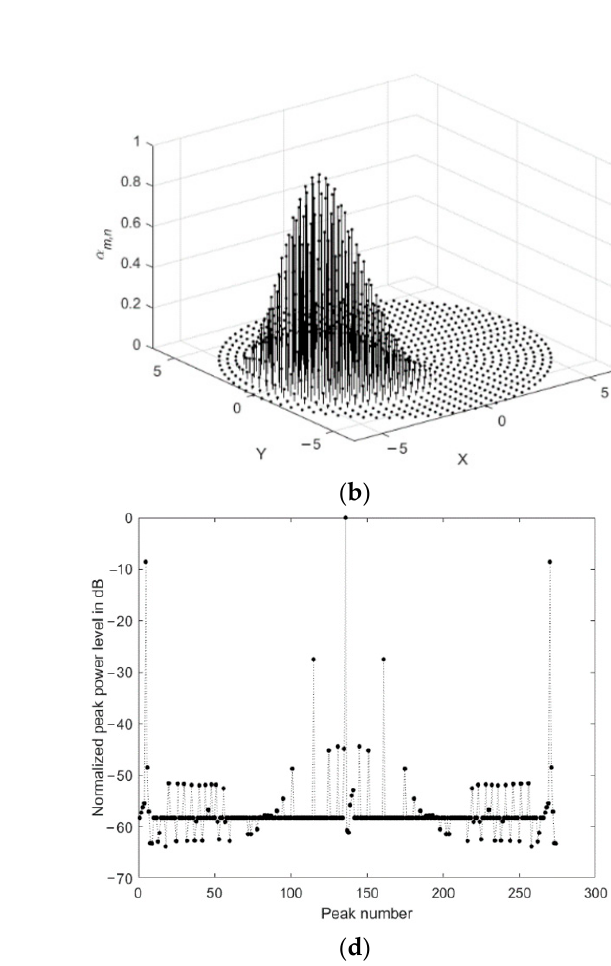
Figure 13. Frontal mainlobe-oriented partial CSC 4 : ( a ) partial array active antenna elements (blue dots), ( b ) amplitude coefficients, ( c ) normalized power pattern (with –50 dB floor), and ( d ) radiation peak levels.